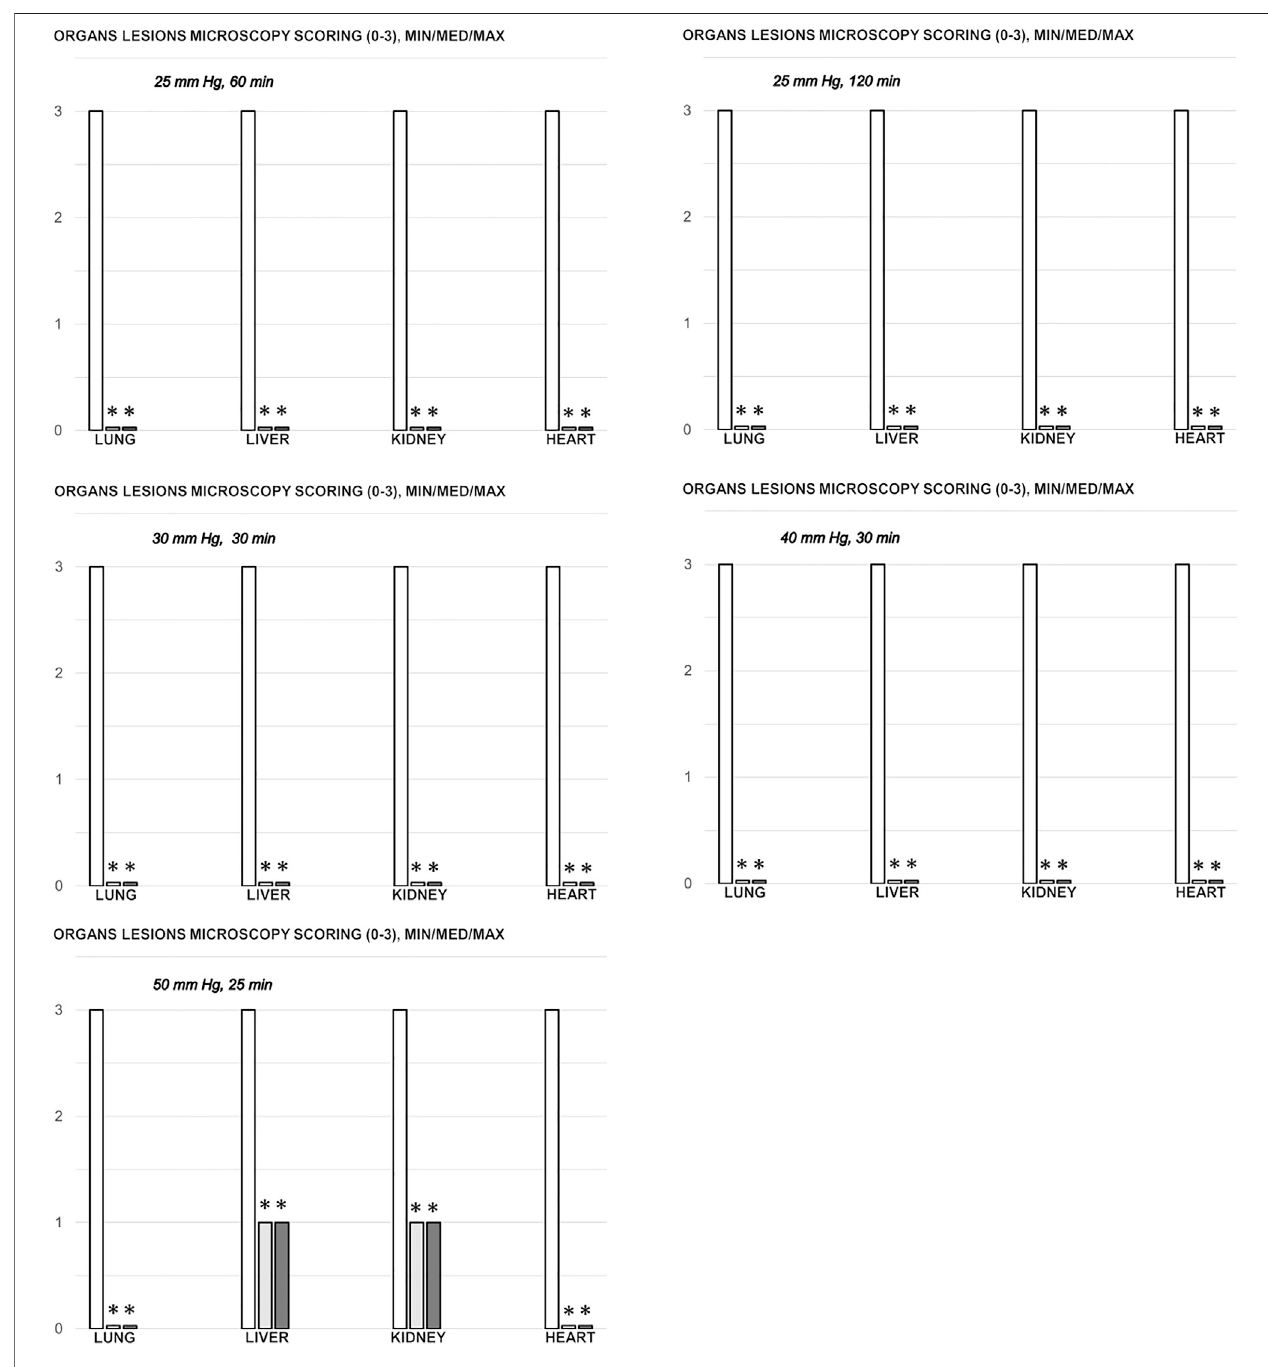
FIGURE 8 | Organs (lung, liver, kidney, heart) microscopy scoring (0 – 3), in the thiopental-anesthetized rats with the increased intra-abdominal pressures at 50 mmHgfor 25 min, at 30 mmHg or40 mmHgfor 30 min, at 25 mmHg for60 min increasedintra-abdominalpressures-time, and in theesketamine-anesthetized rats with the increased intra-abdominal pressures at 25 mmHg for 120 min increased intra-abdominal pressures-time, following medication (BPC 157 10 μ g/kg (light gray bars), 10 ng/kg (dark gray bars); saline 5 ml/kg (white bars)) given subcutaneously at 10 min increased intra-abdominal pressures-time. Minimum (min), maximum (max), median (med), *P ˂ 0.05, vs. control. Figure 9 . Illustrative presentation of gross and microscopic presentation. Gross presentation. Stomach ( a, A ) and liver ( b,B ) (white letters) after the increased intraabdominal pressure and medication (sc) (saline (5 ml/kg, left, stomach and duodenum with multiple small hemorrhagic lesions ( a ), and congested liver ( b ) presentation) or BPC 157 (10 ng/kg, right, stomach and duodenum, and liver A, B ): 25 mmHg (30 min) ( a, A ) and 40 mmHg (30 min) ( b, B ). A camera attached to a VMS-004 Discovery Deluxe USB microscope (Veho, United States). Microscopy presentation. Stomach ( a, A ) and colon ( b, B ) (black letters) presentationinratswiththeincreasedintra-abdominalpressureat50 mmHgfor25 mintreatedat10 minincreasedintra-abdominalpressuretimewithsaline(control, a, b )orBPC157( A,B ).Thecontrolgroupshowedmarkedhyperemia and congestion ofthestomachwall( a )and areduction ofthecolonic cryptswithfocaldenudationof the super fi cial epithelia ( b ). BPC 157-treated rats exhibit presentation close to normal gastrointestinal tract presentation ( A, B ). (HE; a, A , magni fi cation × 100, scale bar 200 μ m; b, B , magni fi cation × 200, scale bar 100 μ m).